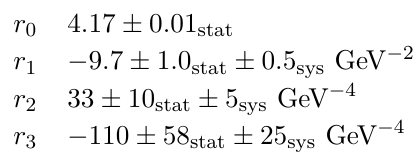
Table 6 . Final estimates for the Taylor-series coefficients of the ghost propagator. In each line, the first uncertainty is statistical while the second is systematic, obtained from the spread of values from the different